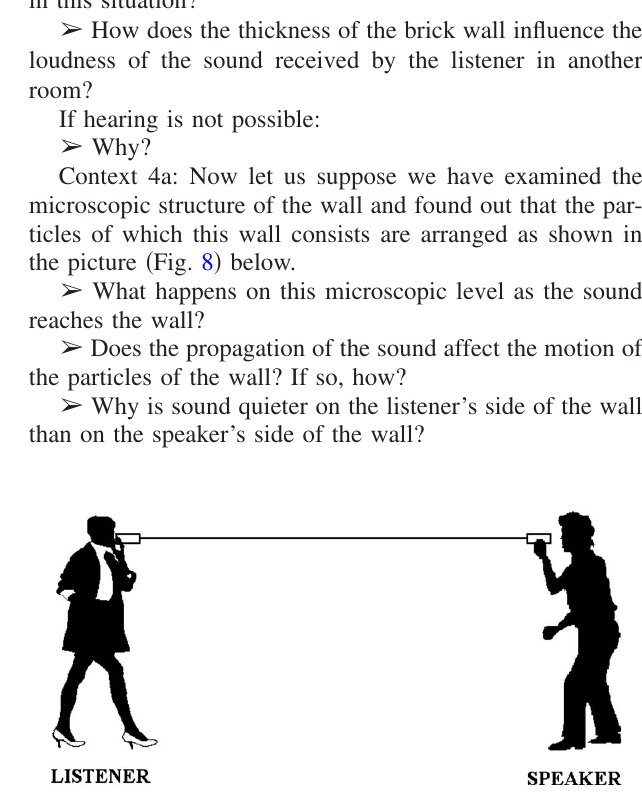
FIG. 9. Picture available to students for better understanding of the situation and for optional drawing during discussion related to context 5 in interview protocol.